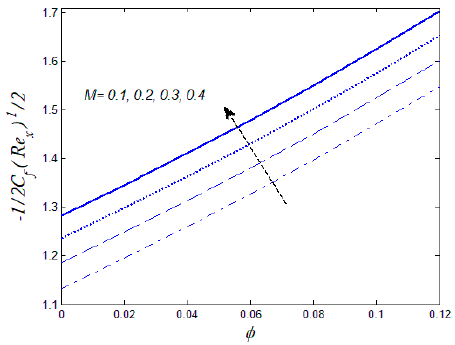
Figure 14. Upshot of M and φ on wall shear stress − 1